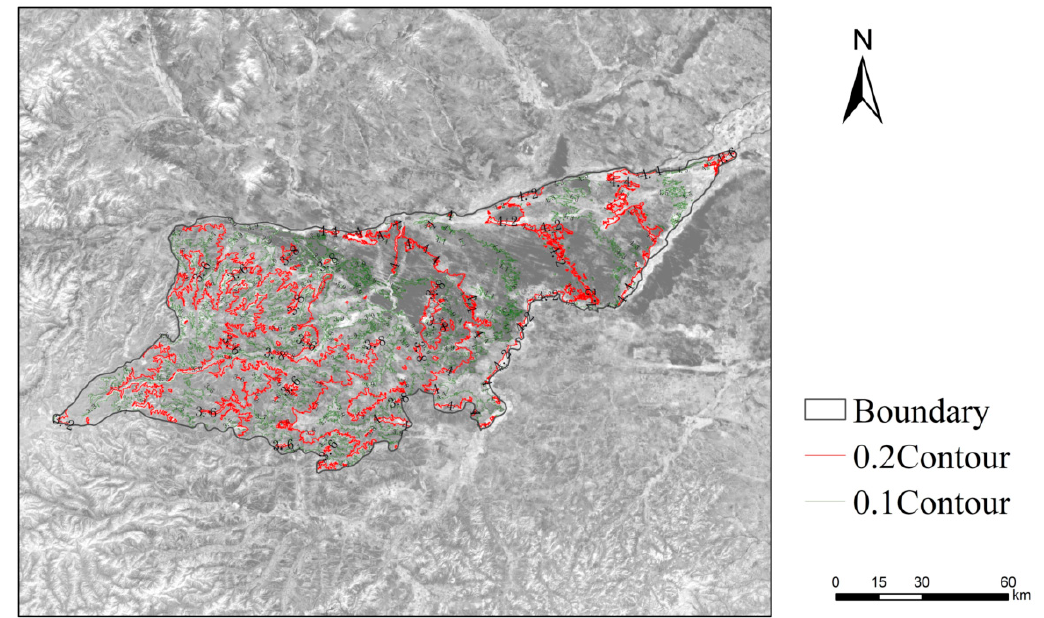
Figure 4. Distribution map of training sample points.